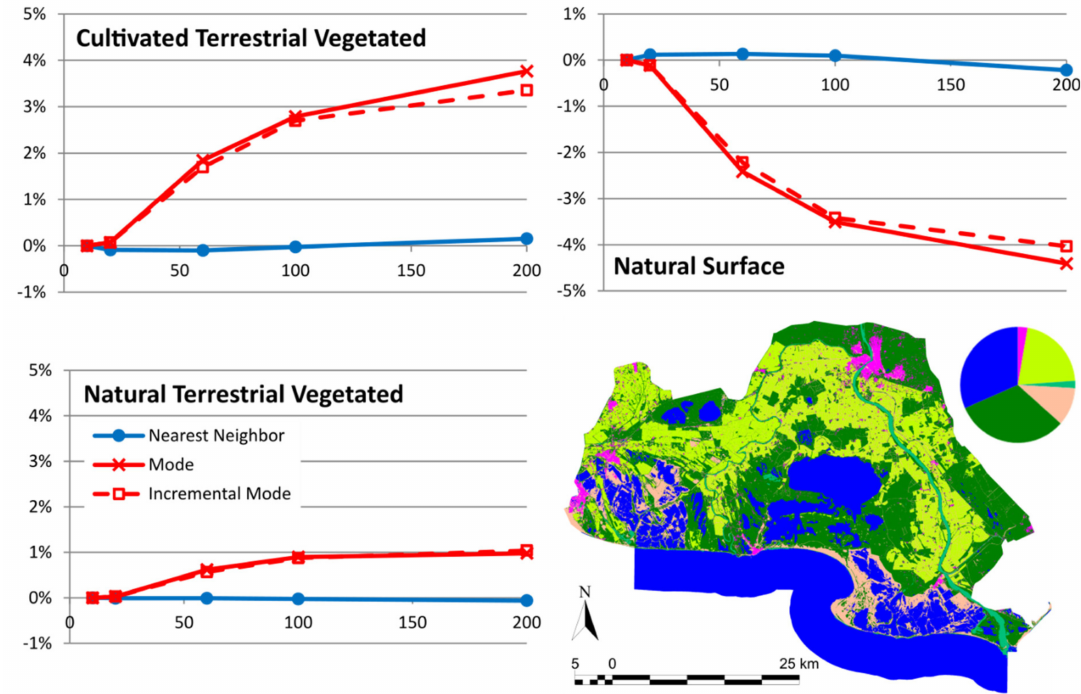
Figure 4. Variation of Cultivated Terrestrial Vegetated , Natural Surface and Natural Terrestrial Vegetated categories in Camargue protected area in relation to the area at original resolution of the same category. The original land cover map of the protected area, as well as a pie chart indicating the proportion for each category, are also shown (map legend is the same as in Figure